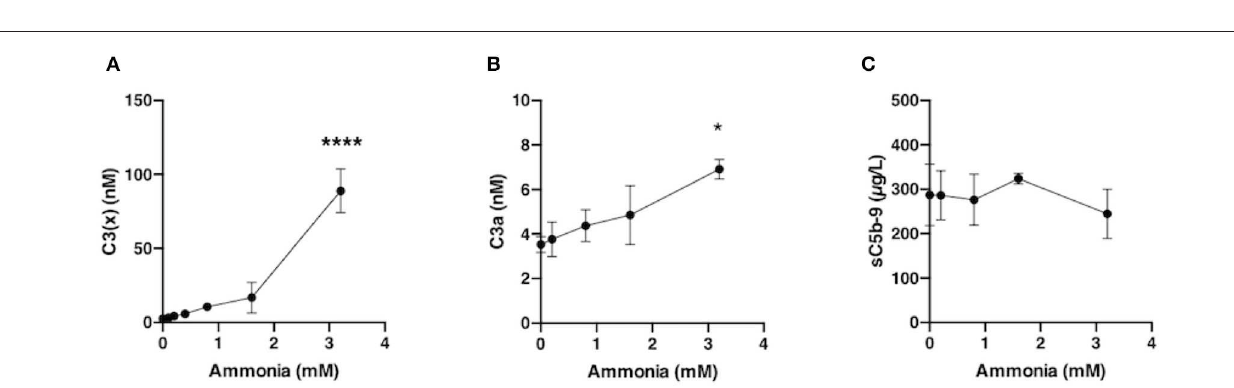
C3/C3b and C3(x) 1 / C3(x) 2 was similar in all cases, where C3(x) 2 was by far the least